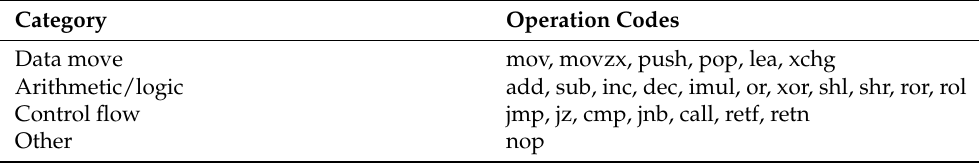
Figure 7. Opcode sequence after